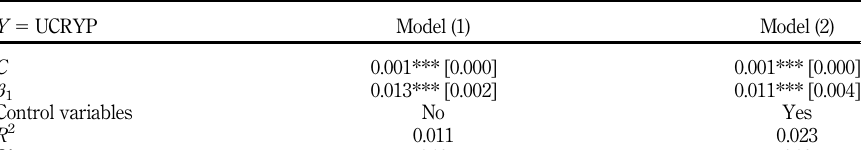
Table 3. The predictive power of EPU on the